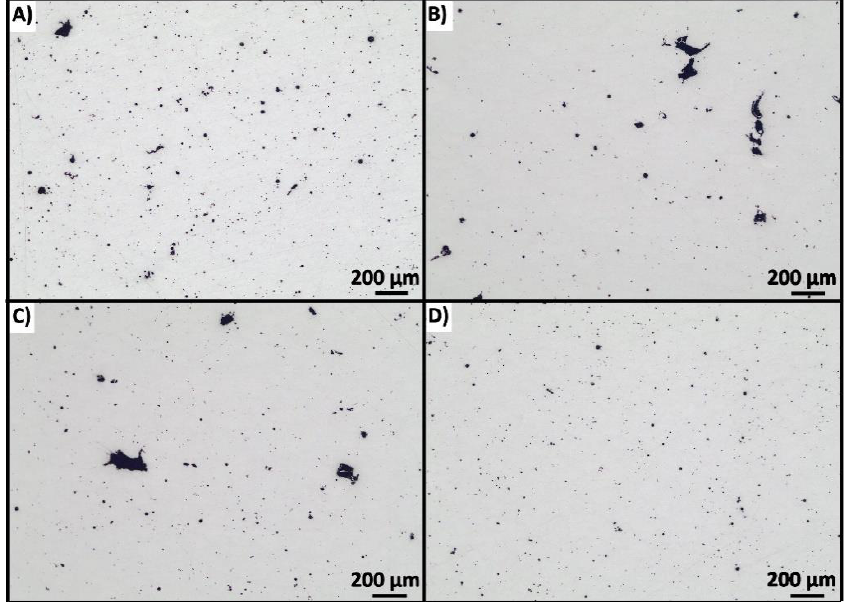
Figure 9. Optical microscope images of sections of cubes built with the following parameter combi- nations. ( A ) h = 0.16 mm, v = 1500 mm/s, VED = 26 J/mm 3 ; ( B ) h = 0.18 mm, v = 1500 mm/s, VED = 23 J/mm 3 ; ( C ) h = 0.14 mm, v = 1700 mm/s, VED = 26 J/mm 3 ; ( D ) h = 0.1 mm, v = 2000 mm/s, VED = 31 J/mm 3 .